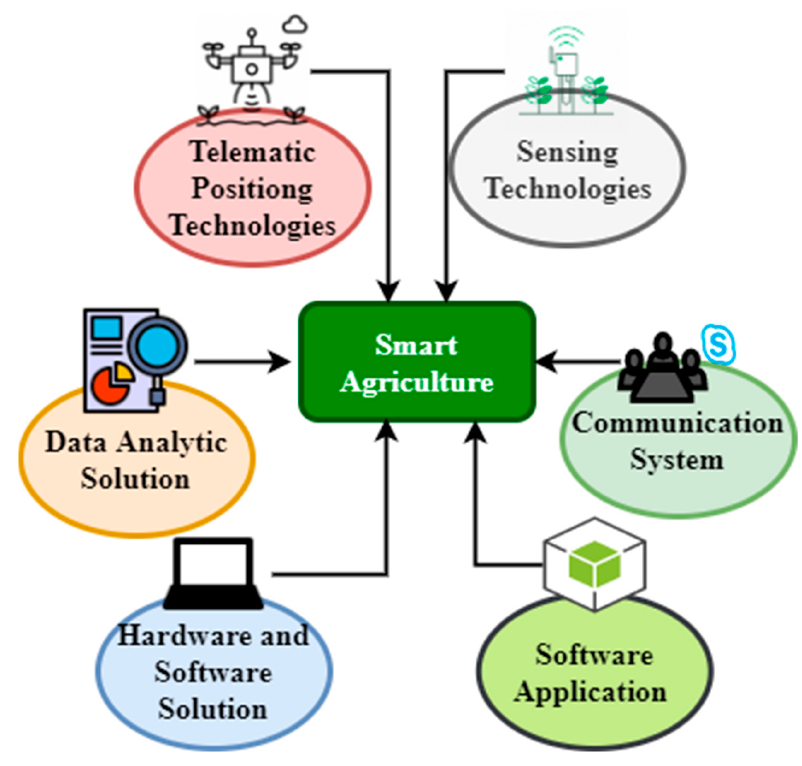
Figure 5. Smart agriculture-based system technologies.